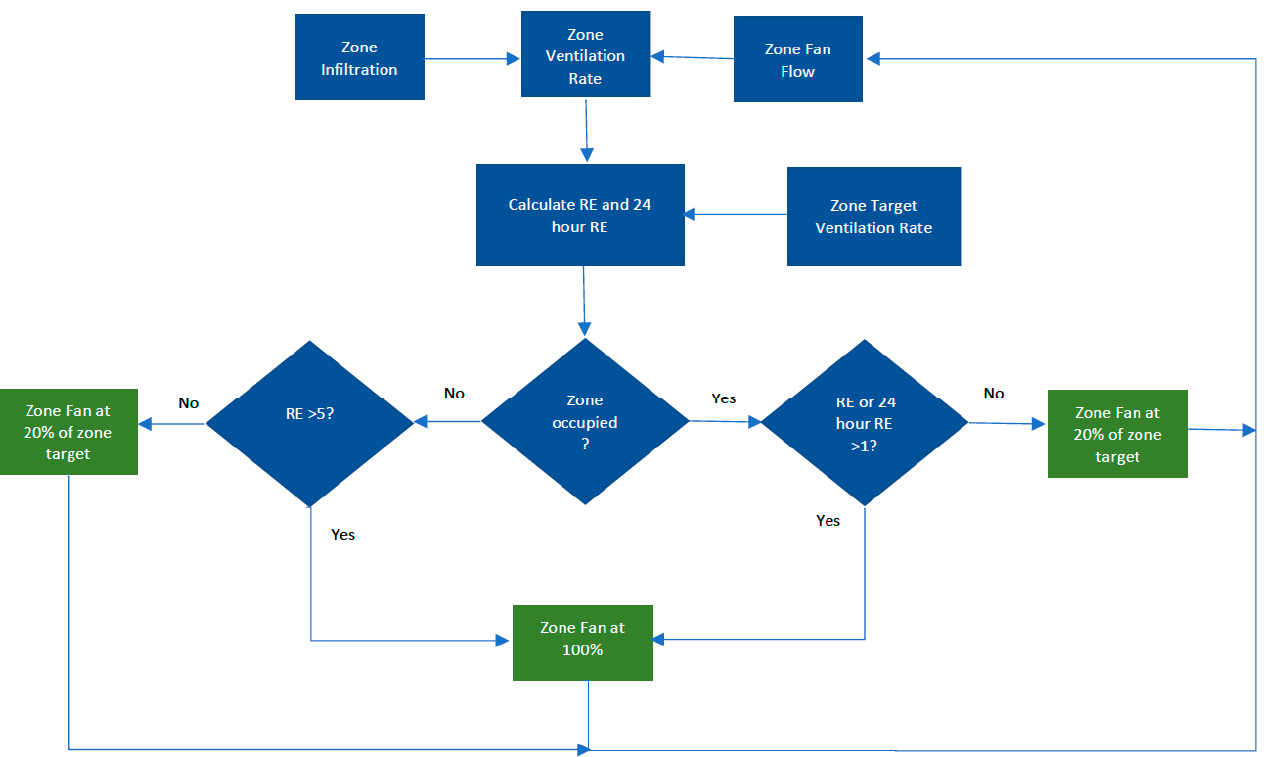
Figure 1. Example controller flowchart for the zoneExposure controller. This control process is for a single zone and is repeated for each zone in the dwelling. “RE” is the relative exposure calculated for an individual zone.